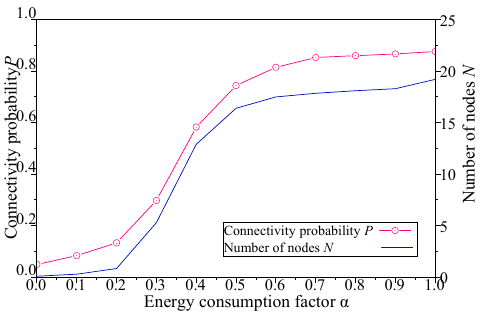
Figure 10. Influence of α on network connectivity probability and number of nodes.